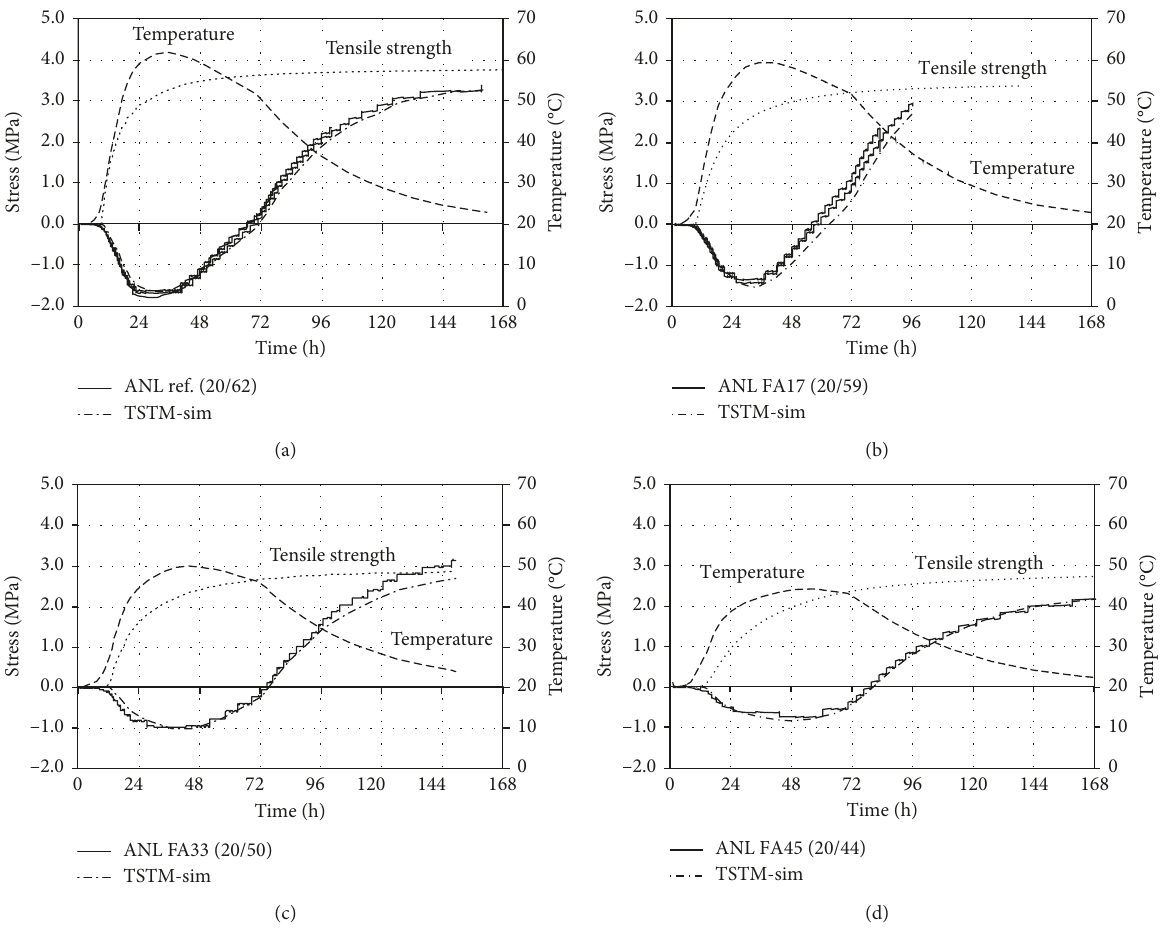
Figure 6: Measured and calculated stress development: ANL ref. (a), ANL FA17 (b), ANL FA33 (c), and ANL FA45